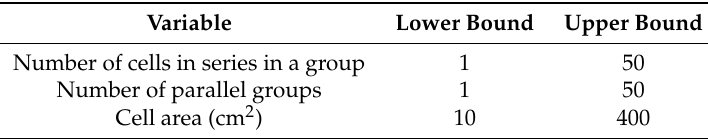
Table 2. Bounds of the design variables (from references